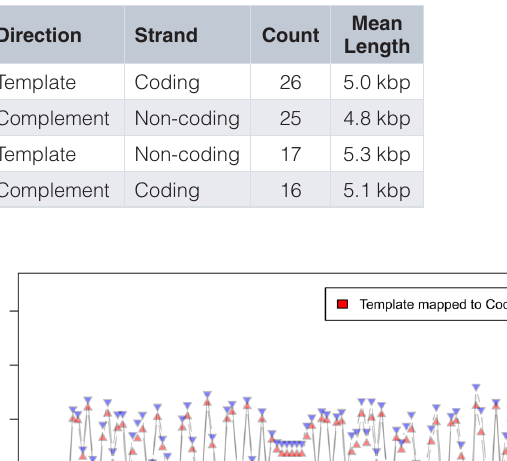
Table 3. mtDNA read groups. Statistics for the four different read mapping groups, showing reads that mapped to the Nippostrongylus brasisiliensis mitochondrial genome with over 50% coverage.